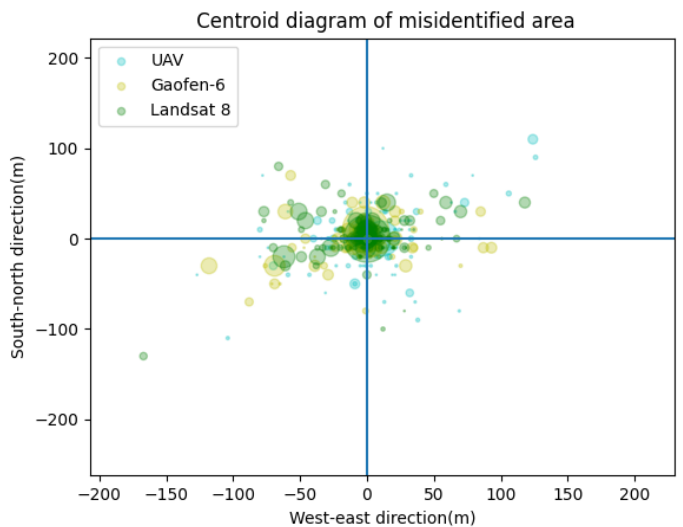
Figure 9. Schematic diagram of the location of each undetected area from the mass center of the landslide (The zero point position is the mass center of the complete landslide area. The positions of the points are relative to the mass center of the complete landslide area. The size of the circle represents the area of the undetected landslide).